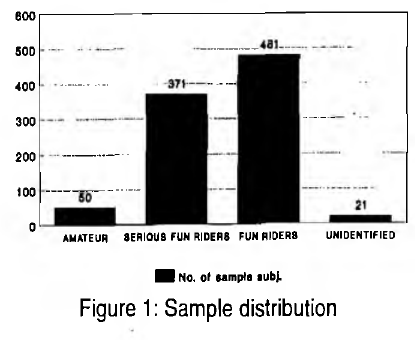
Figure 1: Sample distribution As only 36% of the fun-riders group were members of cycling clubs or PPA's, the authors expected the occurrence of in­ juries amongst the fun-rider group to ex­ ceed that of the other two groups.